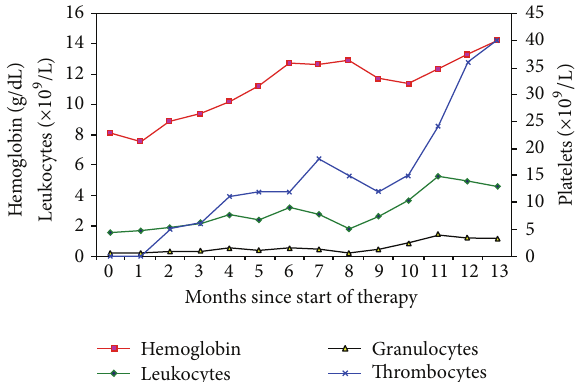
Figure 2: Development of hematological values before and during